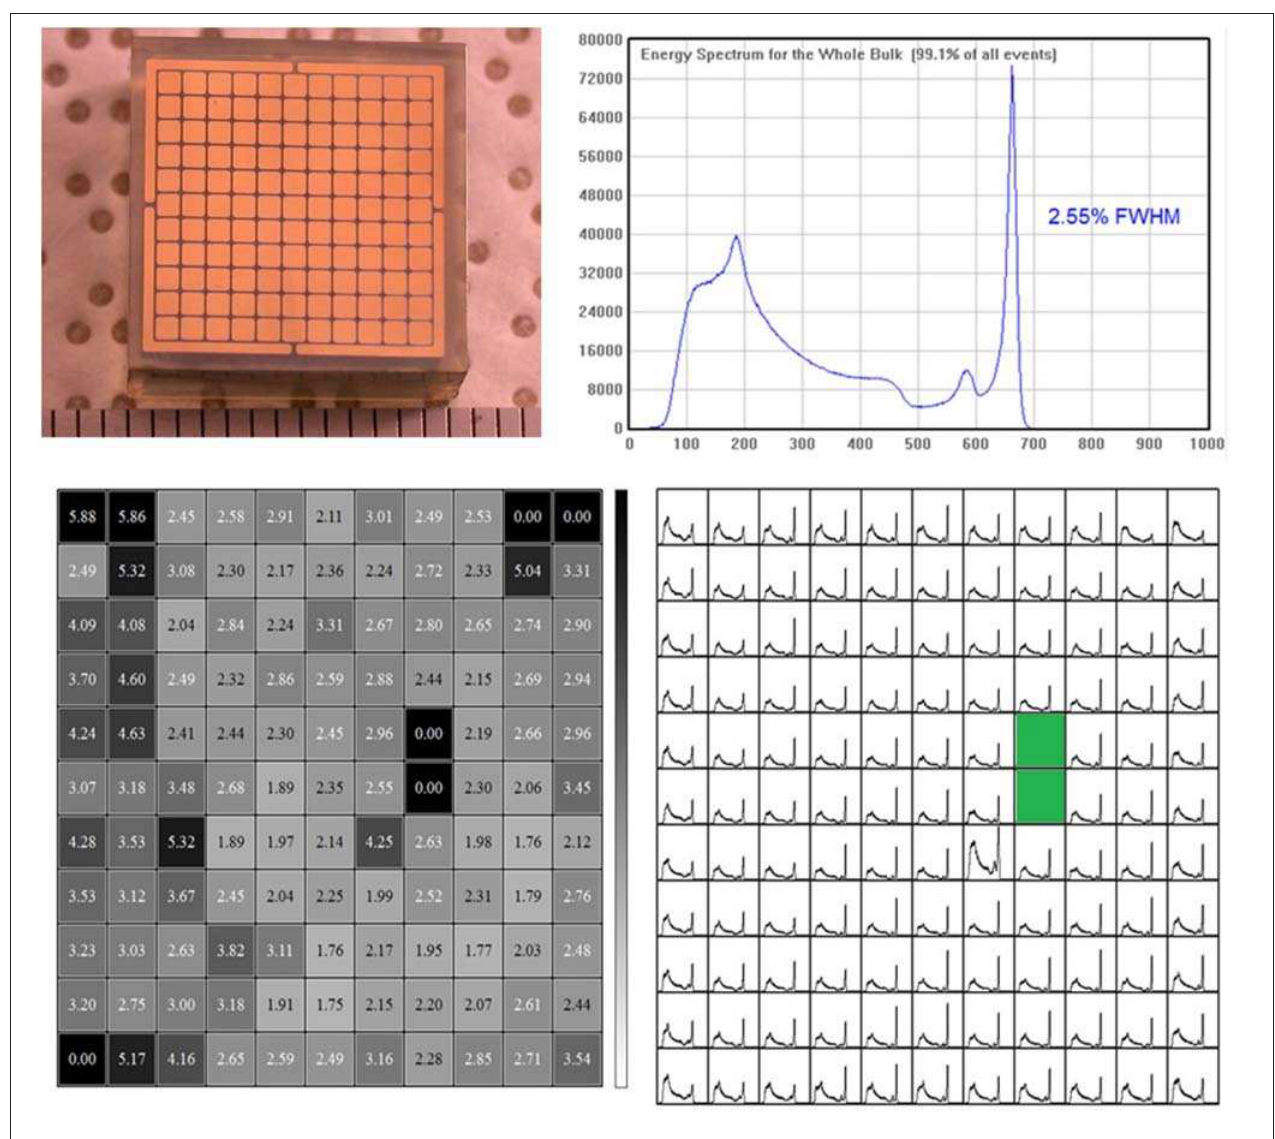
FIGURE 11 | Top left: 11 × 11 array ( + guard ring) (5mm thick, 1mm pitch). Top right: depth corrected 137 Cs spectrum from single pixel events for the full array. Bottom left: energy resolution (% FWHM at 662 keV) for the raw spectra. Bottom right: raw, uncorrected 137 Cs spectra for each pixel of the